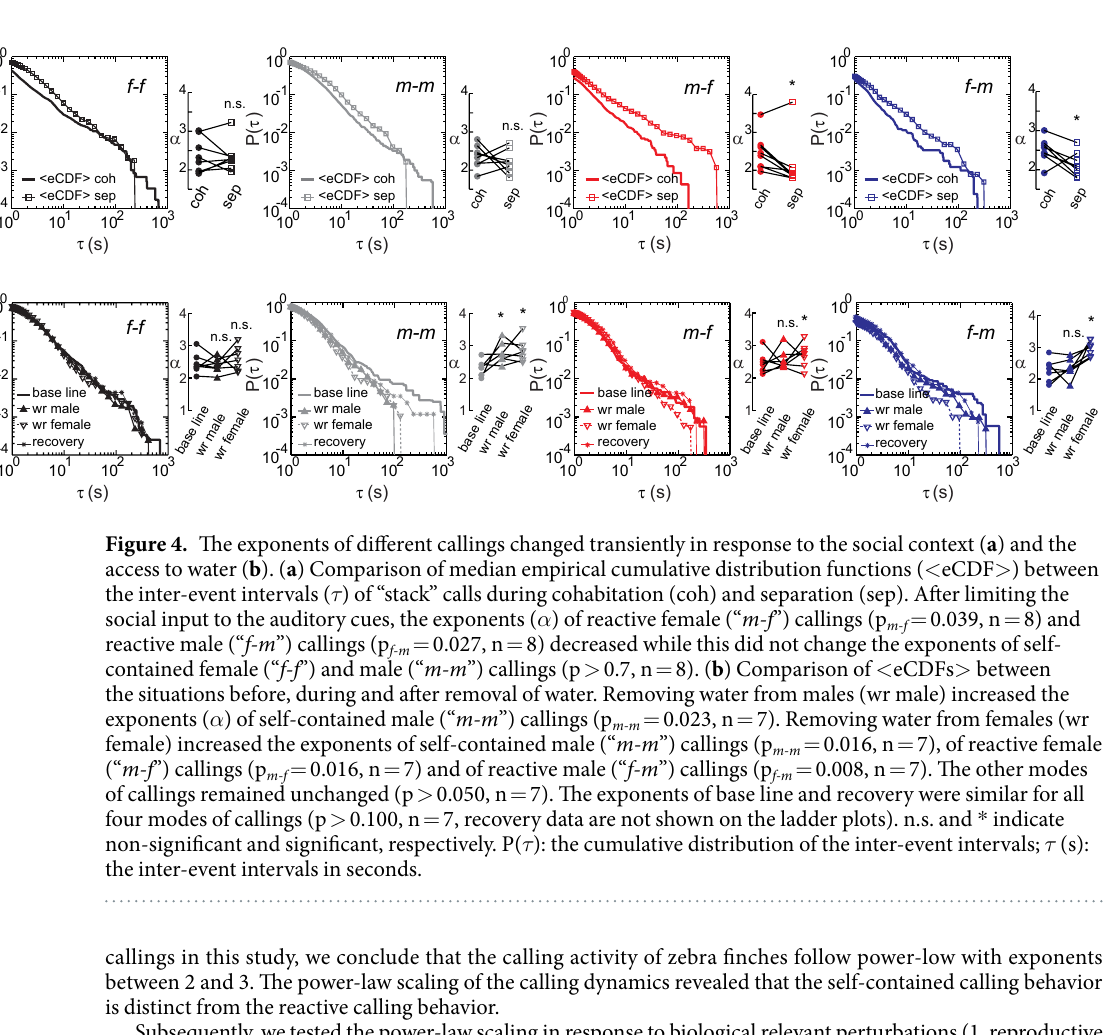
callings in this study, we conclude that the calling activity of zebra finches follow power-low with exponents between 2 and 3. The power-law scaling of the calling dynamics revealed that the self-contained calling behavior is distinct from the reactive calling behavior. Subsequently, we tested the power-law scaling in response to biological relevant perturbations (1. reproductive partner is out of sight but in hearing range; 2. water is transiently not available) in eight zebra finch pairs (Fig. 4). The heavy-tailed dynamics were maintained unchanged during separation with acoustical interconnection ( < eCDF > sep) as compared to that during cohabitation ( < eCDF > coh) in all four modes of callings. The expo- nents of the self-contained female (p f-f = 0.578) and male (p m-m = 0.371) callings persisted unchanged as indicated by a two-sided Wilcoxon signed-rank test (n = 8), whereas the exponents of the reactive female (p m-f = 0.027) and male (p f-m = 0.039) callings decreased during separation with acoustical interconnection as indicated by a right-sided Wilcoxon signed-rank test (Fig. 4a, n = 8). This indicates that the self-contained callings are indeed self-contained and not affected by the social-sensory environment, whereas the reactive callings depend on multiple-sensory cues. However, we could not exclude the possibility that some reactive callings were by chance. Such incidental “reactive” callings can be considered as an experimental noise, as any other experimental noise. Nevertheless, the perturbation experiments suggest that the incidental noise is not the main factor in this system. To probe the plasticity of the self-contained callings, we performed a water-removal experiment with seven pairs. Water-removal did not change the overall power-law distribution of calling intervals. Water-removal from males resulted in a significant (left-sided Wilcoxon signed-rank test, n = 7) increase of the exponents of the self-contained male callings (p m-m = 0.023, Fig. 4b). The exponents of the self-contained female callings, the reactive female and reactive male callings remained unchanged by water-removal from males (Fig. 4b, p > 0.050, two-sided Wilcoxon signed-rank test, n = 7). As indicated by left-sided Wilcoxon signed-rank tests (n = 7), water-removal from females not only increased the exponents of the self-contained male callings (p m-m = 0.016) but also increased the exponents of the reactive female (p m-f = 0.016) and reactive male (p f-m = 0.008) callings (Fig. 4b). Neither water-removal from males nor from females had an effect on the exponents of the self-contained female callings (Fig. 4b). Although the exponents of self-contained female callings had not changed, the distribu- tions of call rates in both females and males changed in response to water-removal. The call rates became more irregular in male compared with females (Supplementary Fig. S2, Supplementary Text S1). Finally, the exponents returned to their initial values after the end of the treatments (Fig. 4b), i.e. the exponent (signature) of both reactive and self-contained callings of a particular zebra finch is homeostatically regulated over at least 10 days.